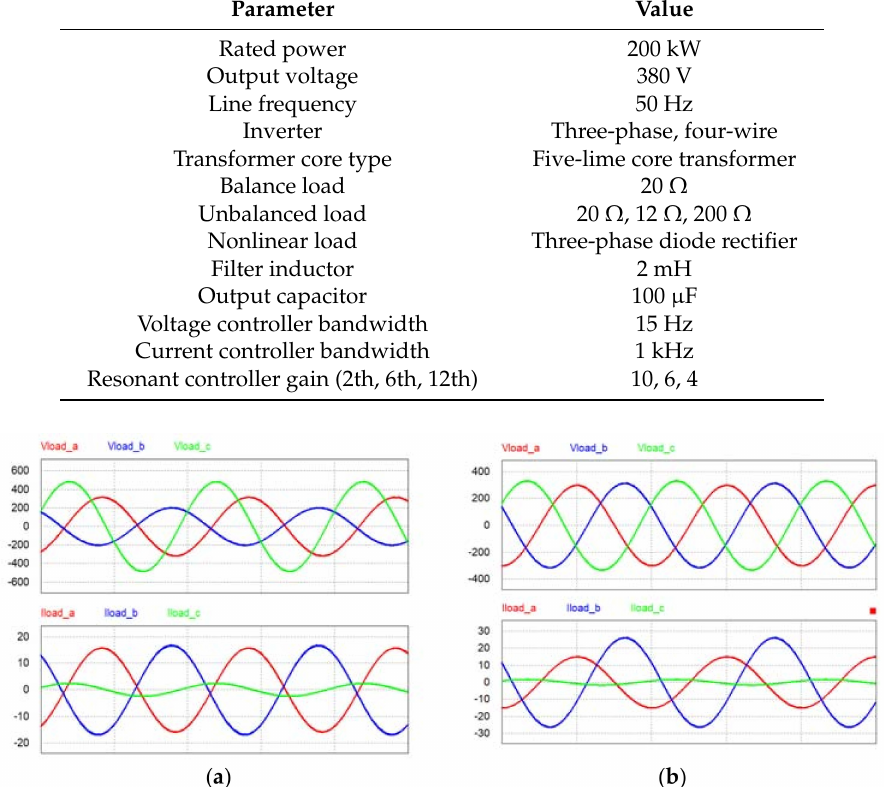
Figure 19. Simulation results of a five-limb core-type transformer under unbalanced load conditions. ( a ) dq controller; ( b ) dq 0